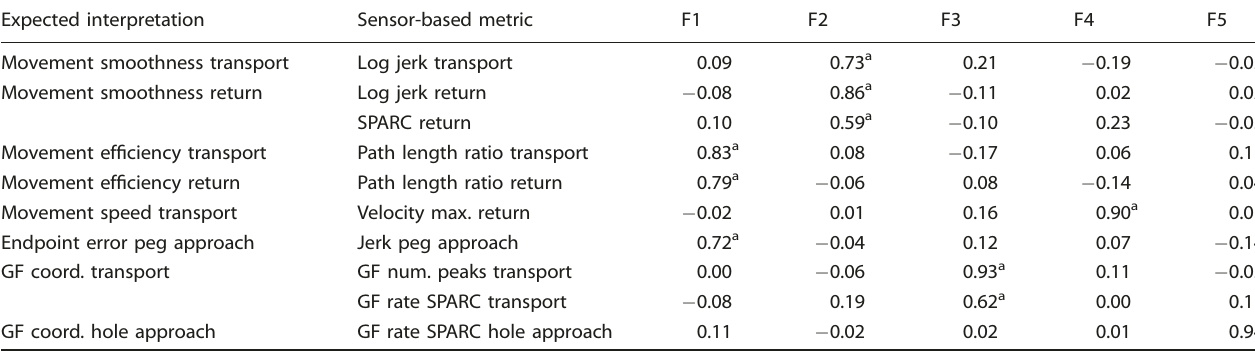
Table 4. Structural validity: exploratory factor